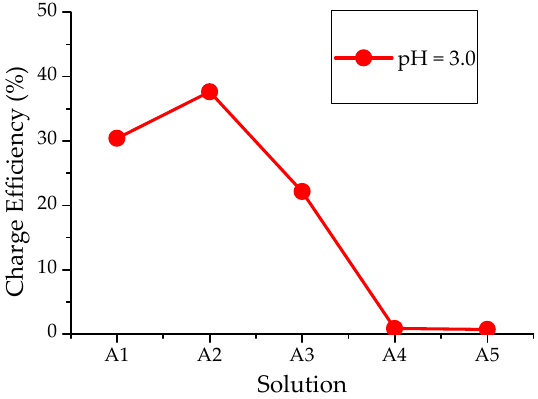
Figure 3. Charge e ffi ciency of solutions A. Data obtained from cyclic voltammograms. Figure 3. Charge efficiency of solutions A. Data obtained from cyclic voltammograms.